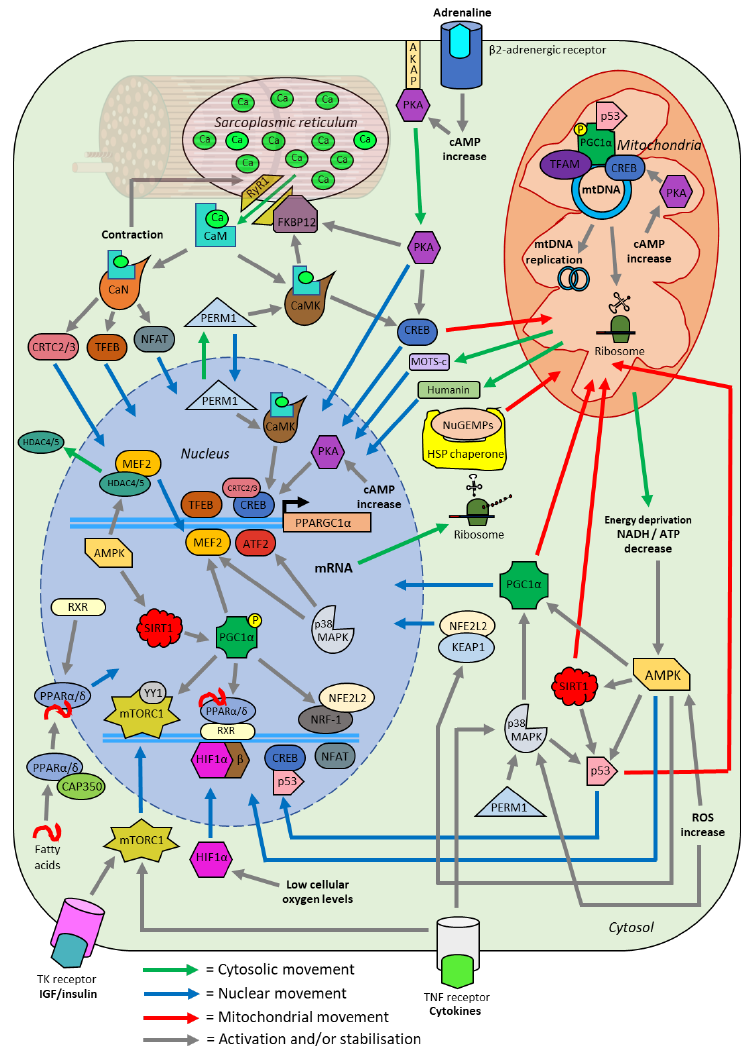
Figure 7. Schematic overview of the effects of a single session of exercise on transcription factor localisation. A single session of exercise causes various acute homeostatic perturbations within skeletal muscle, initiating signalling cascades (grey lines) in numerous pathways. These pathways facilitate the movement of transcription factors into the nucleus (blue line), cytosol (green line), and mitochondria (red line). These transcription factors lead to the upregulated expression of genes encoding mitochondrial proteins in a process termed mitochondrial biogenesis. All of the interactions depicted have either been experimentally verified or are likely to occur based on the current available evidence. ATP; adenosine triphos- phate. NAD; nicotinamide adenine dinucleotide. cAMP; cyclic adenosine monophosphate. ROS; reactive oxygen species.